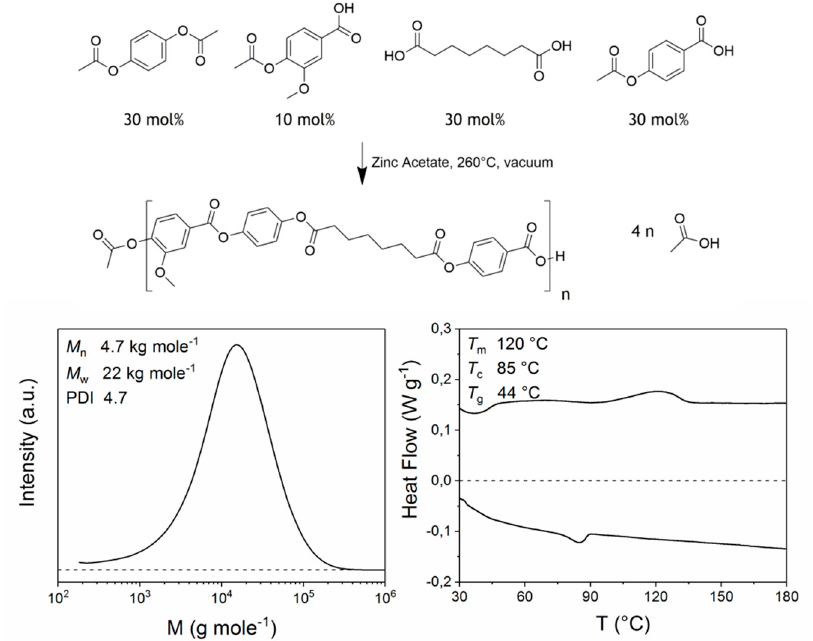
Figure 2. Reaction scheme of the LCP synthesis, resulting in a random copolymer ( top ), molecular weight distribution of the LCP ( left ), and differential scanning calorimetry (DSC) thermogram (endo up) depicting the cooling and second heating of the LCP taken at a rate of 10 °C min − 1 ( right ).